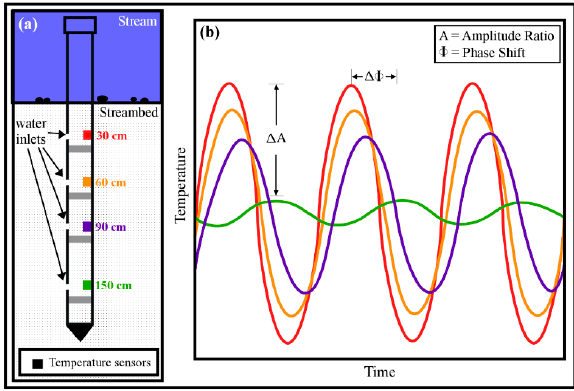
Figure 2. ( a ). A nested streambed sampler with four temperature sensors at 30, 60, 90, 150 cm depths. Each temperature sensor was isolated with foam sealant. ( b ) Phase shift and amplitude attenuation of sinusoidal thermal signals with increasing depth. The amplitude of thermal signals decreases, ΔA , and the signal is delayed, shift in phase ( Δϕ) , with increasing depth in the streambed (graphic modified from [7] .